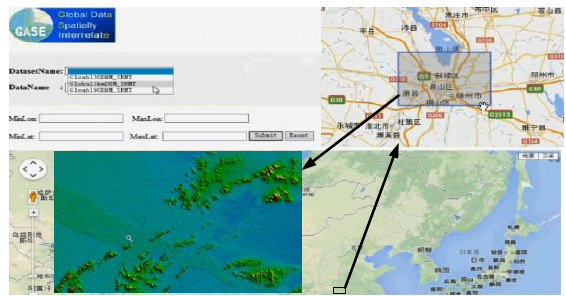
Fig.8 Retrieving DEM in Xuzhou region from GASE.